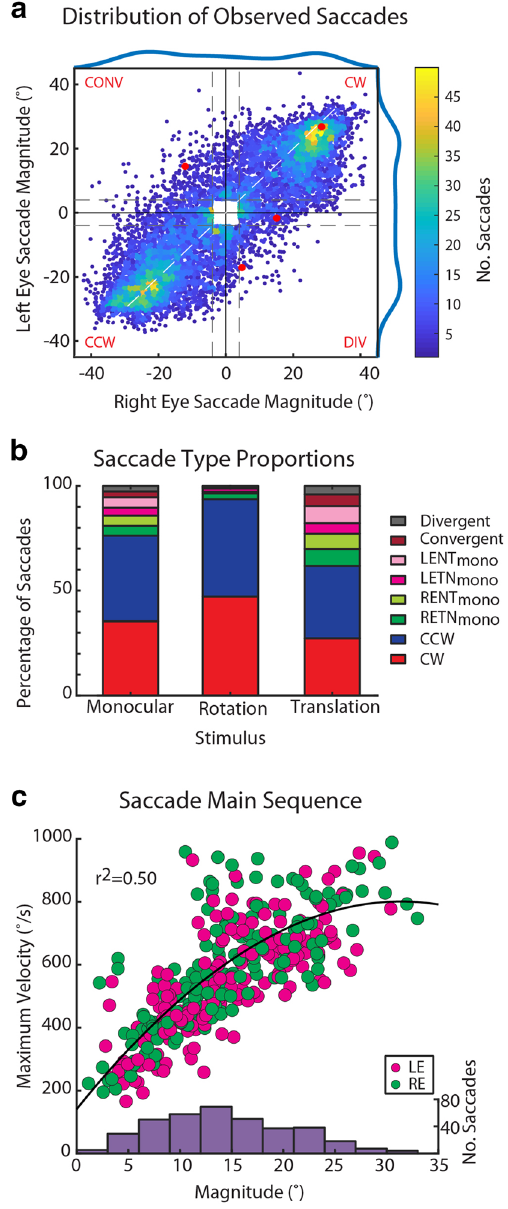
Figure 3. Characterization of binocular saccades. ( a ) Heat scatter plot 48 showing the distribution of binocular optokinetic saccade magnitudes in all analyzed calcium imaging experiments (n = 30 larvae, 146 recordings, 9,866 data points). The saccades shown in Fig. 2b are plotted in red. Only saccades larger than 4° were included in further analysis for technical reasons. The classification thresholds for monocular, clockwise (CW), counter- clockwise (CCW), convergent (CONV) and divergent (DIV) are indicated as dashed grey lines, and the outer quadrants are labelled in red. ( b ) Proportion of saccade types per protocol phase. Note that the translation and unbalanced monocular stimulus phases elicited higher proportions of disconjugate saccades than the rotation phase. ( c ) Dependence of maximum saccade velocity on saccade magnitude (main sequence). Spontaneous clockwise saccades of both eyes (LE, RE) were recorded at 750 fps (n = 24 zebrafish larvae). A histogram of saccadic velocities is shown in brown on top. The distribution was fitted using a cubic polynomial with a resulting R 2 value of 0.5. LETN left eye temporal nasal; RENT right eye nasal temporal; LENT left eye nasal temporal; RETN right eye temporal nasal; mono: monocular